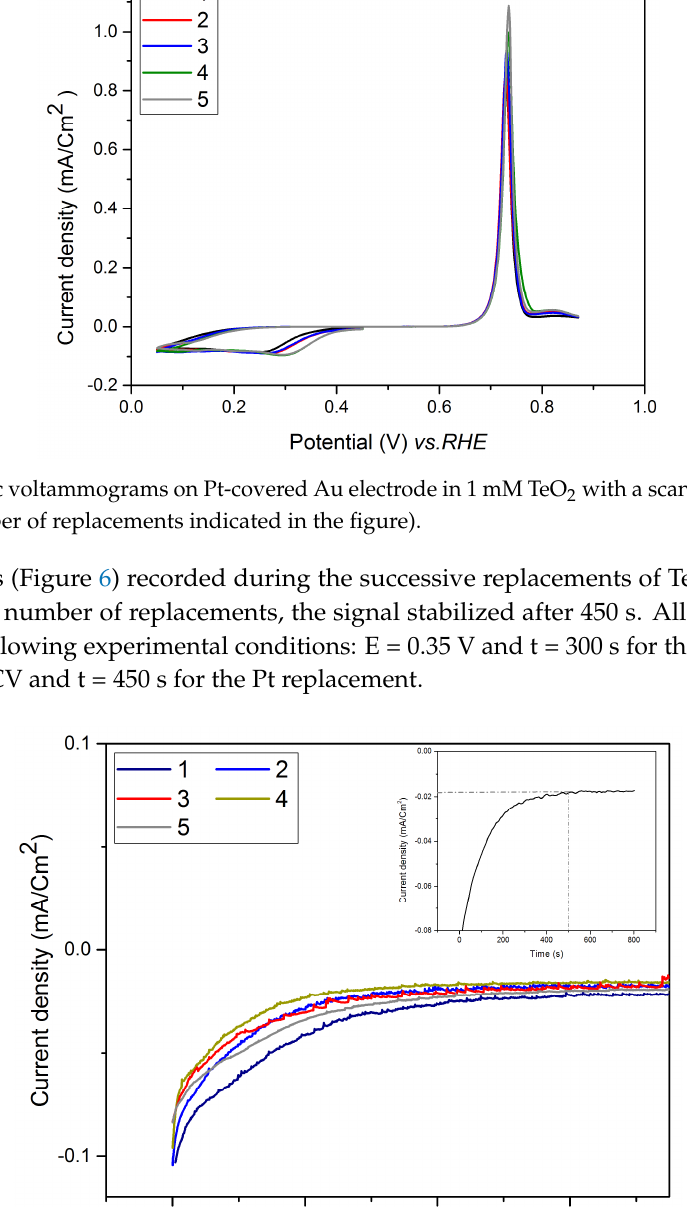
Figure 4. Chronoamperometric curve of the galvanic replacement of Te by Pt at open circuit voltage (OCV).